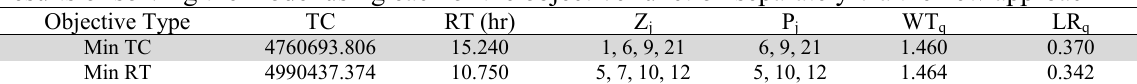
Results of solving the model using each of the objective function separately via the new approach